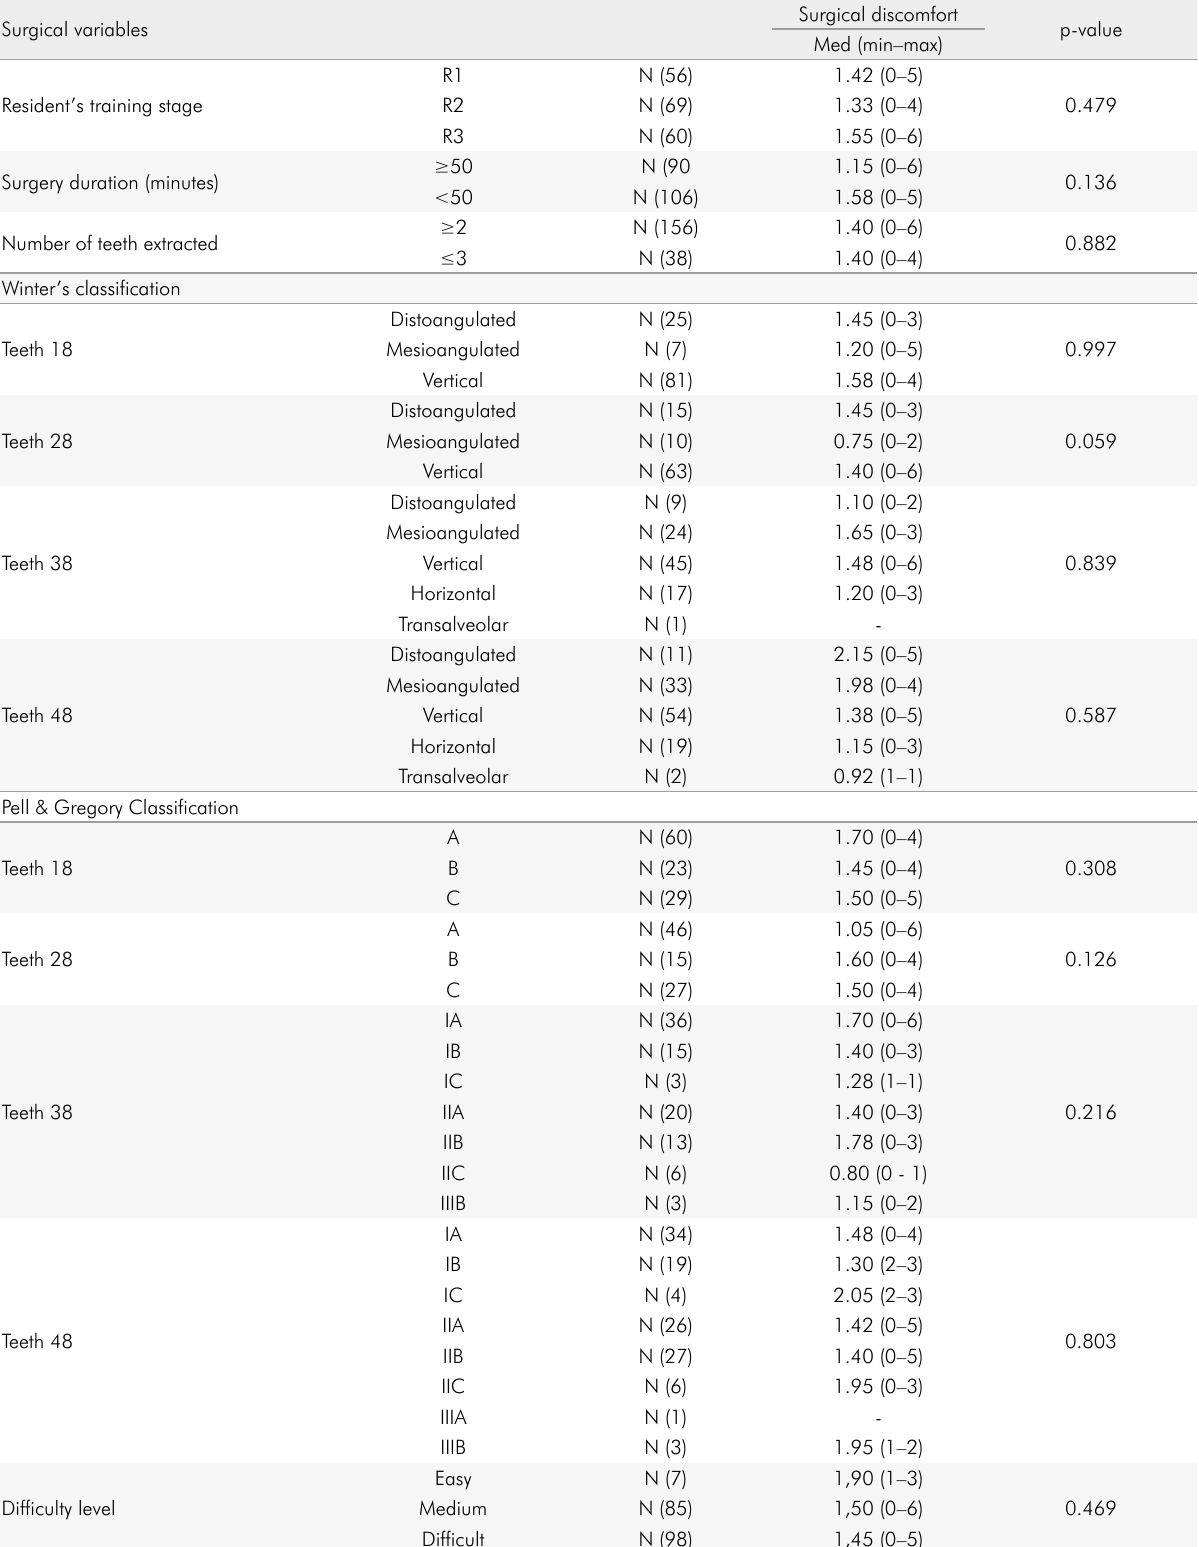
Table 3. Median (min and max) scores for surgical discomfort according to surgical variables. Surgical